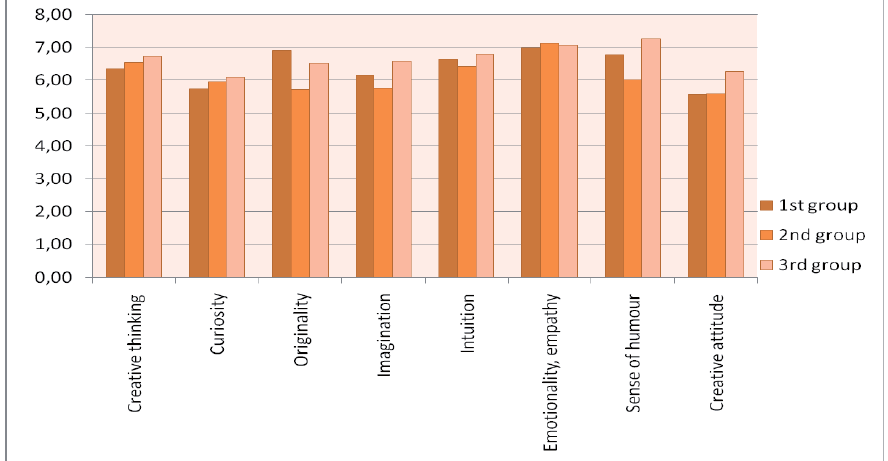
Fig. 3. Comparison of creativity indicators in three groups under